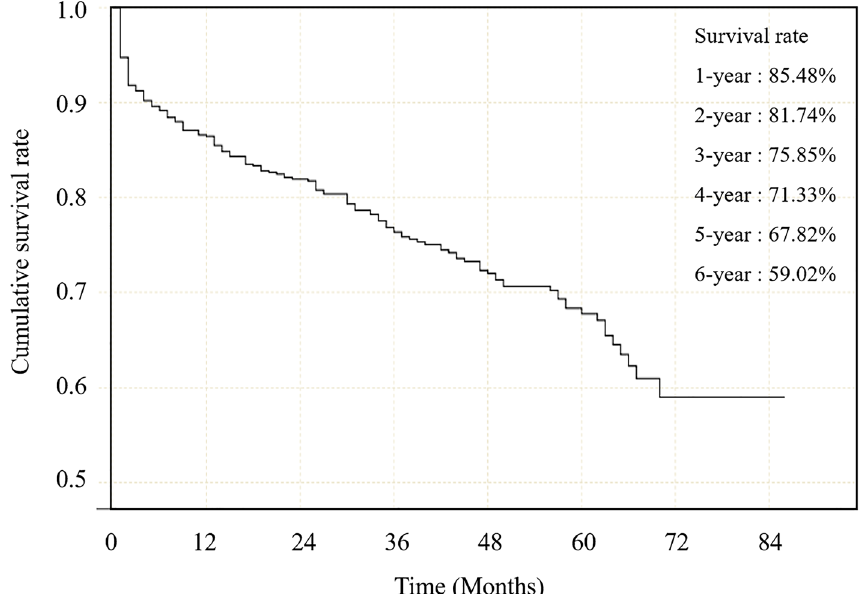
Figure 2. Survival curve of 692 sICH patients.